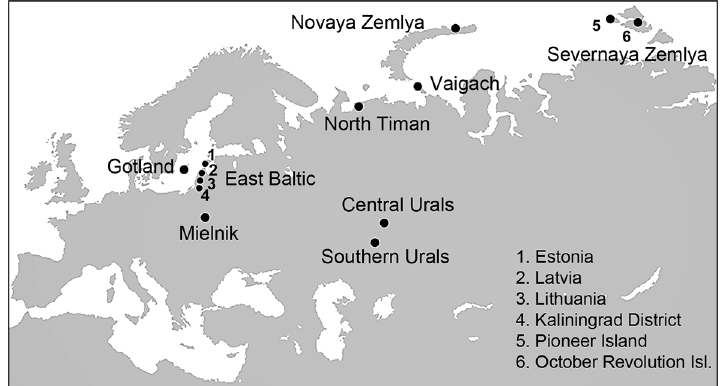
Fig. 1. Locations of Silurian cyathaspidids in Northern Eurasia: the East Baltic (1, Estonia; 2, Latvia; 3, Lithuania; 4, Kaliningrad District); Gotland Island, Sweden; Mielnik, East Poland; North Timan, Vaigach Island, Northern Island of the Novaya Zemlya Archipelago, the Central Urals, the Southern Urals, Severnaya Zemlya Archipelago (5, Pioneer Island; 6, October Revolution Island), Russia. Vector graphics from the